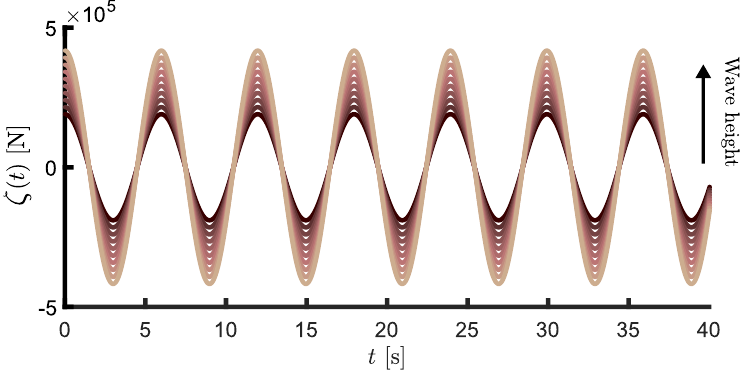
Figure 4. Set of inputs ζ i used to approximate the associated